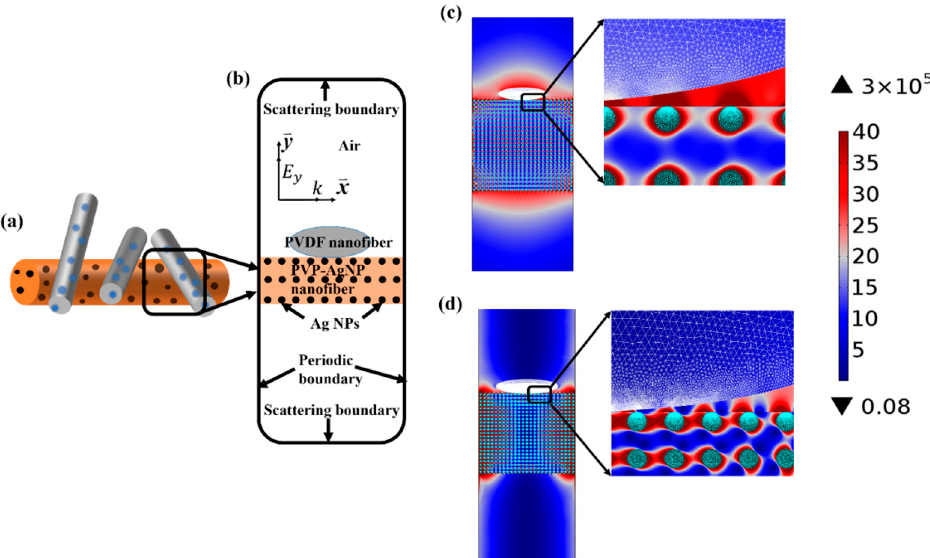
Figure 6. ( a ) The schematic diagram of the intertexture of PVP-Ag nanofibers and PQD nanofibers on the interface between PVP-Ag and PQD layers; ( b ) a cross-section of the computational geometry. The calculation dimension is truncated by scattering boundary conditions and periodic boundary conditions. The incident optical wave is polarized along y -axis, traveling along 𝑥 -axis. 𝐸 (cid:3052) and k are the incident electric field and wavevector, respectively; ( c ) and ( d ) Plots of relative optical